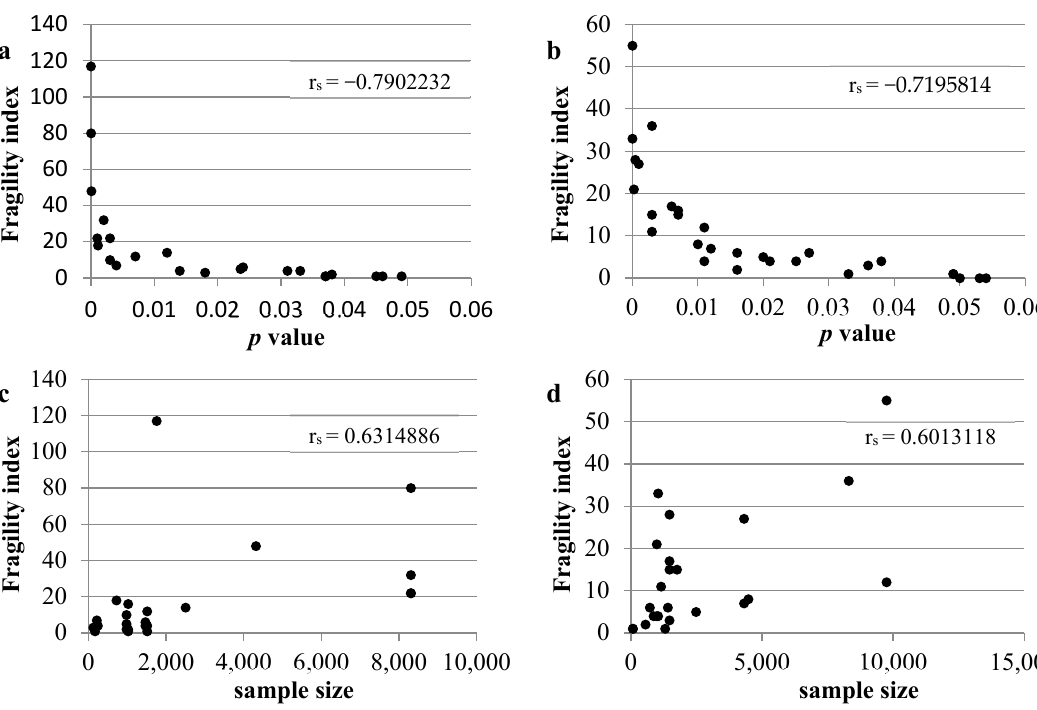
Figure 3. Scatter plots of fragility index. Fragility index versus p value for primary ( a ) and secondary ( b ) outcomes; fragility index versus sample size for primary ( c ) and secondary ( d ) outcomes.